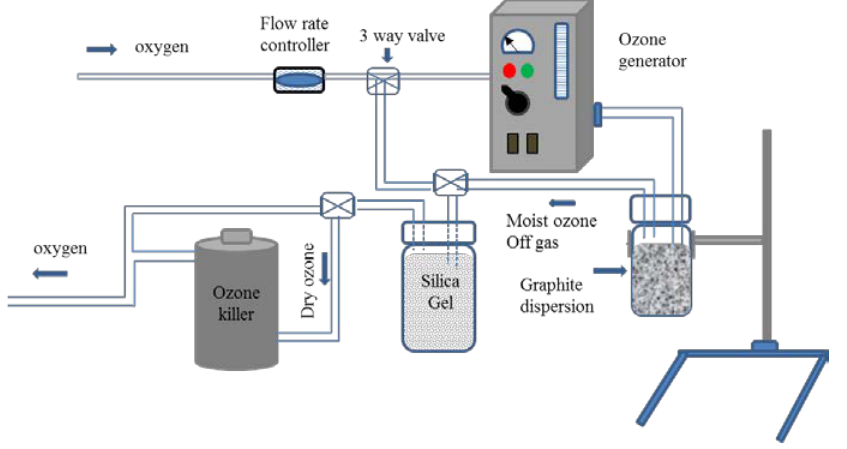
Figure 1. Experimental setup used for ozone generation and treatment of graphite suspension.